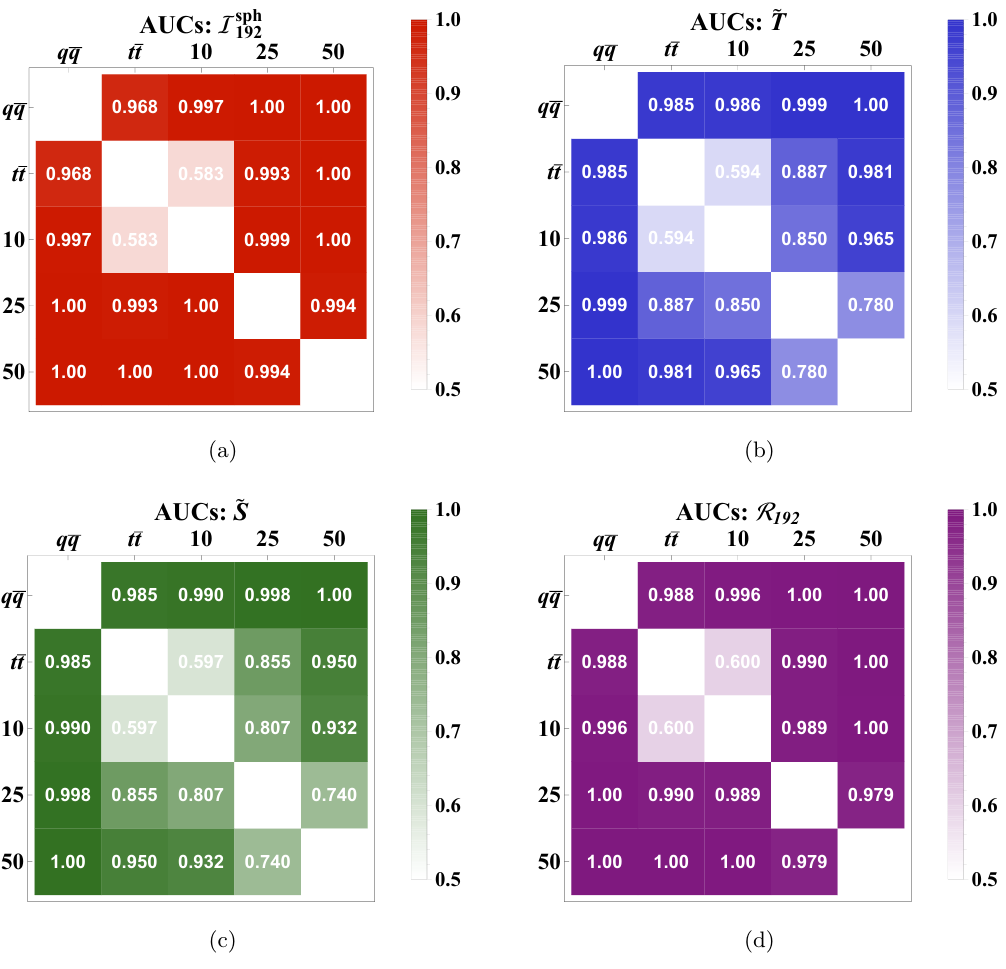
Figure 10 . The discrimination power between each pair of e + e (cid:0) samples from (cid:12)gures 8 and 9, as summarized by the AUC for (a) event isotropy with n = 192, (b) thrust, (c) sphericity, and (d) the isotropy/thrust ratio. Darker shades indicate more e(cid:14)cient discrimination, with the darkest indicating complete separation. Apart from t (cid:22) t vs. N = 10, event isotropy has excellent discrimina- tion power between any pair of samples. Sphericity and thrust are nearly saturated for the larger N -body samples, and therefore have smaller AUC